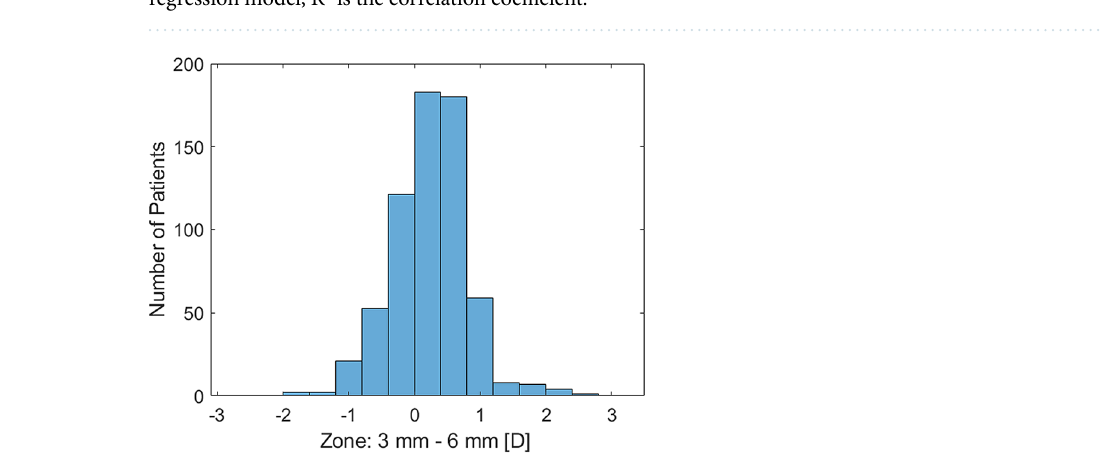
Figure 5. The distribution of the magnitude of astigmatism difference, calculated for each subject as the subtraction of astigmatism at 3 mm from that at 6 mm. Positive values indicate a reduction in corneal astigmatism in the mid-periphery. The corneas count with no change of corneal astigmatism was equally distributed between the first positive and negative